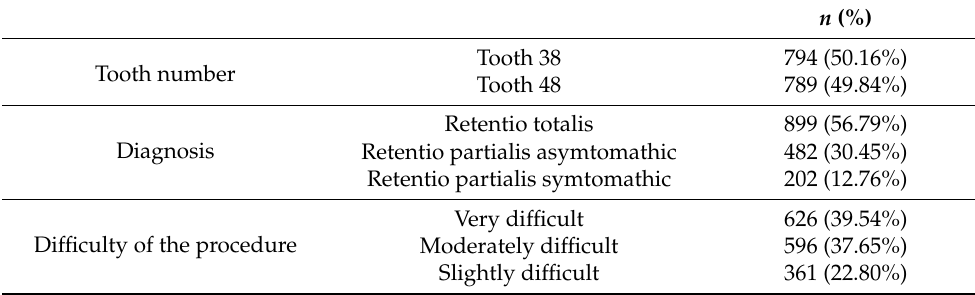
Table 2. Characteristics of impacted third molars in the mandible.